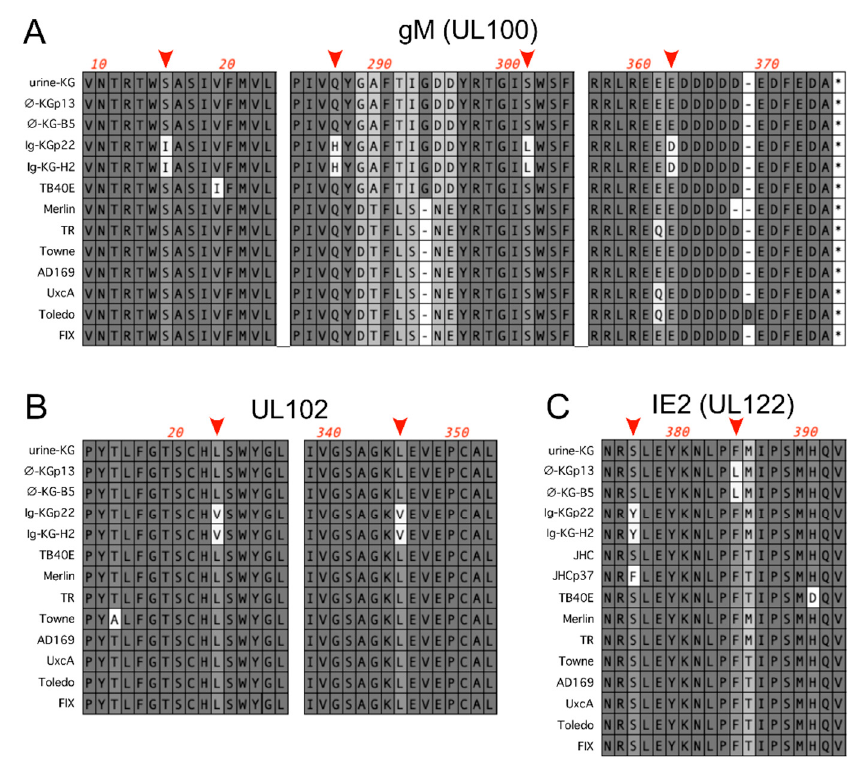
Figure 2. Polymorphisms in gM, UL102, and IE2 arose during serial passage. DNA sequences of the indicated CMV strains were used to predict protein sequences that were then aligned using ClustalW. Selected regions containing polymorphisms of interest (red arrows) are shown for alignments of gM ( A ), UL102 ( B ), and IE2 ( C ).